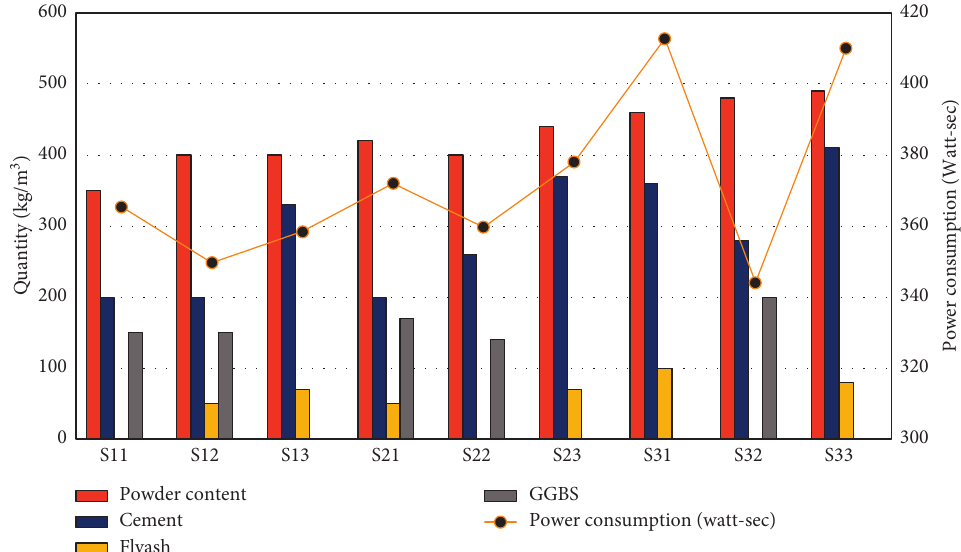
Figure 19: Power consumption is related with total powder content, cement content, fly ash, and GGBS in kg/m 3